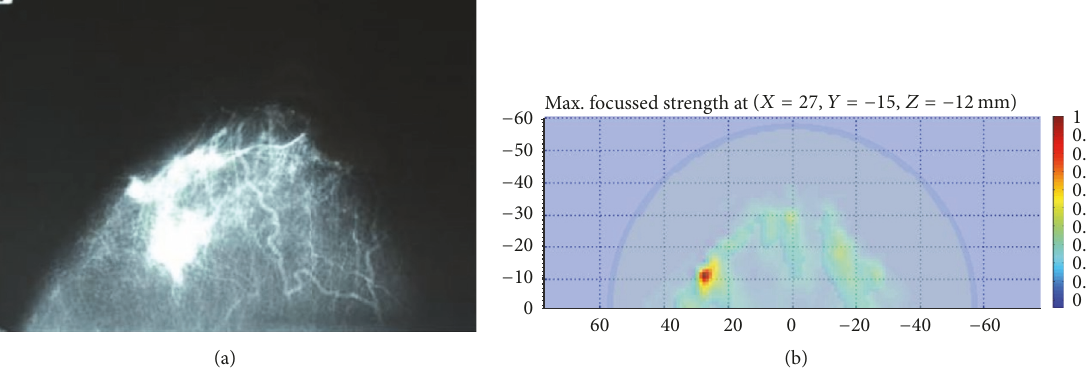
Figure 20: Comparison clinical images of the radar-based microwave imaging and X-ray mammogram result at Bristol University: (a) X-ray mammogram and (b) radar-based UWB microwave system (2D slice through a plane with tumor) [25]. Image copyright IEEE, used with permission.